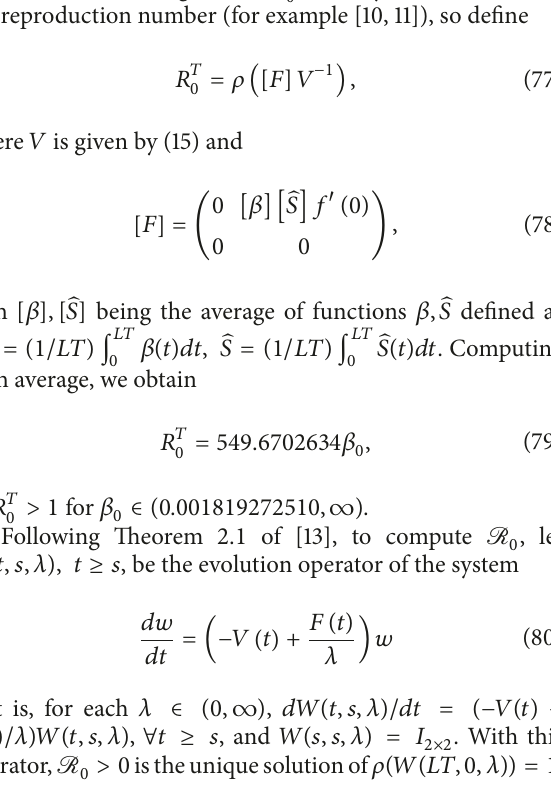
̂𝑆 around 𝑡 = 0 of order 𝑡 10